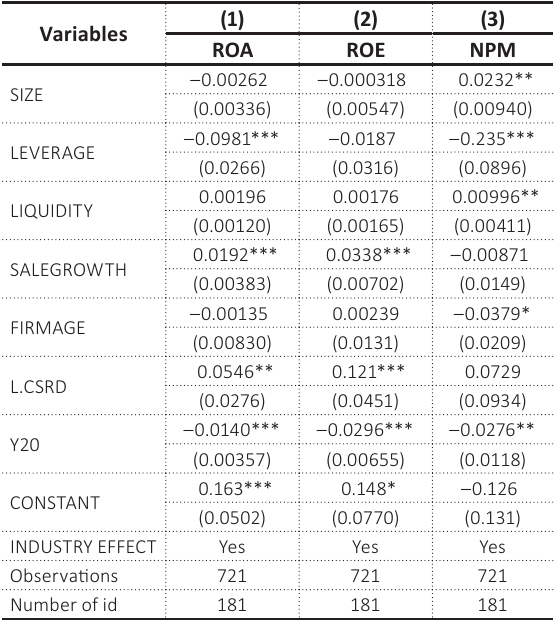
Table 8. Regression results of regression (3)